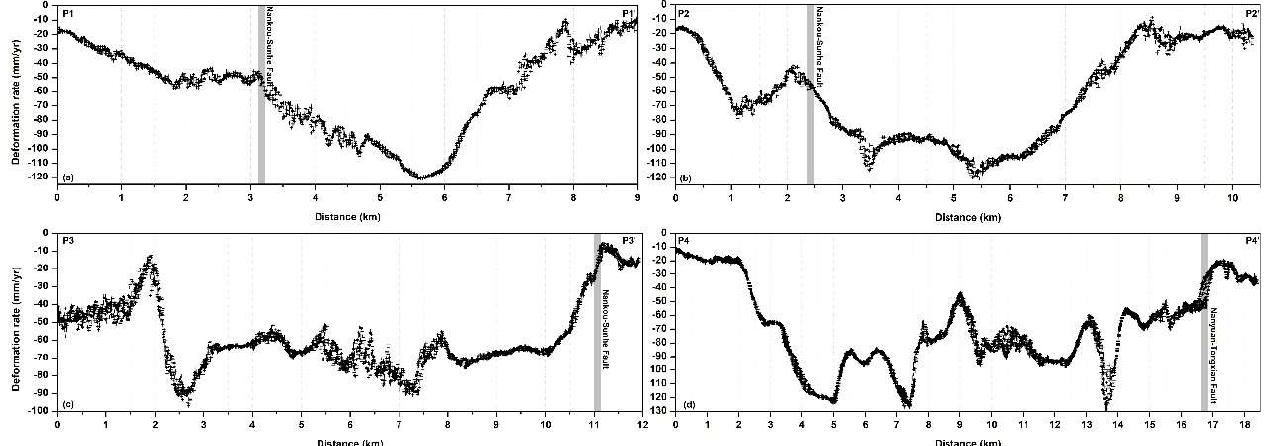
Figure 13. Vertical deformation rates along the profiles of P1P1′, P2P2′, P3P3′ and P4P4′. The loca- tions of these profiles are shown in Figure 4. The gray bar shows the location of the active geological fault shown in Figure 4.